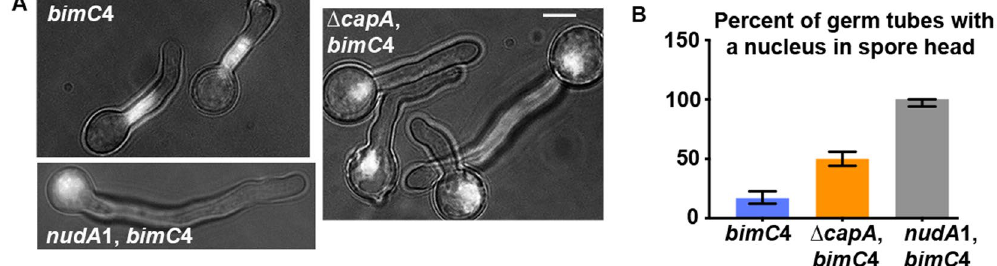
Figure 3. The nuclear-distribution phenotype of the ∆ capA mutant in the bimC 4 background. ( A ) Images showing the position of the single nucleus in the bimC 4 mutant, the nudA 1, bimC 4 double mutant and the ∆ capA , bimC 4 double mutant. Cells were grown at 42 °C or ~8 hours in MM + glucose medium. Bar, 5 μ m. ( B ) A quantitative analysis on the percentage of germ tubes with the single nucleus in the spore head. The percentage values are 16.9% for the bimC 4 single mutant (n = 201), 50.2% for the ∆ capA , bimC 4 double mutant (n = 263) and 100% for the nudA 1, bimC 4 double mutant (n = 60). Error bars represent the 95% confidence interval values generated by Prism 7.